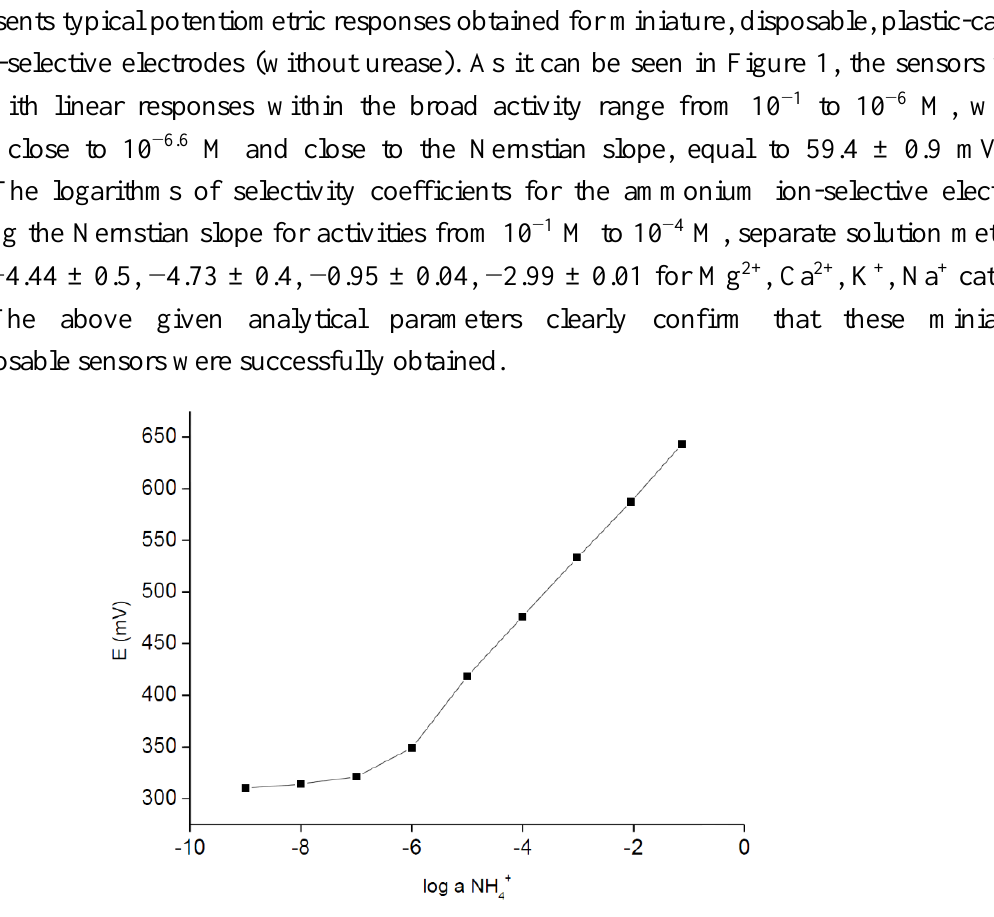
Figure 1. Potentiometric response of ammonium ion-selective carbon-plastic sensor recorded in NH 4 Cl